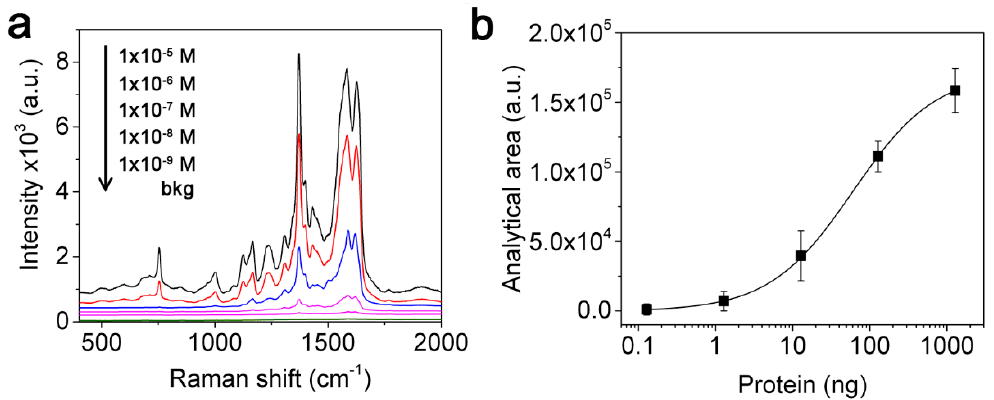
Figure 7. Detection sensitivity of the AgNWs@G-paper substrate. ( a ) SERS spectra of Hb ranging from 1 × 10 − 5 M to 1 × 10 − 9 M (black, 1 × 10 − 5 M; red, 1 × 10 − 6 M; blue, 1 × 10 − 7 M; violet, 1 × 10 − 8 M; purple, 1 × 10 − 9 M; green, background AgNWs@G- paper signal) corresponding to 1.3 μ g to 0.3 ng of protein contained within 2 μ L of analyzed sample volume. The background signal produced by the naked substrate is also displayed. ( b ) Correlation between the 1378 cm − 1 band area of Hb and protein amounts (error bars represent the SD). Spectra and data points represent the average from 20 acquisitions.